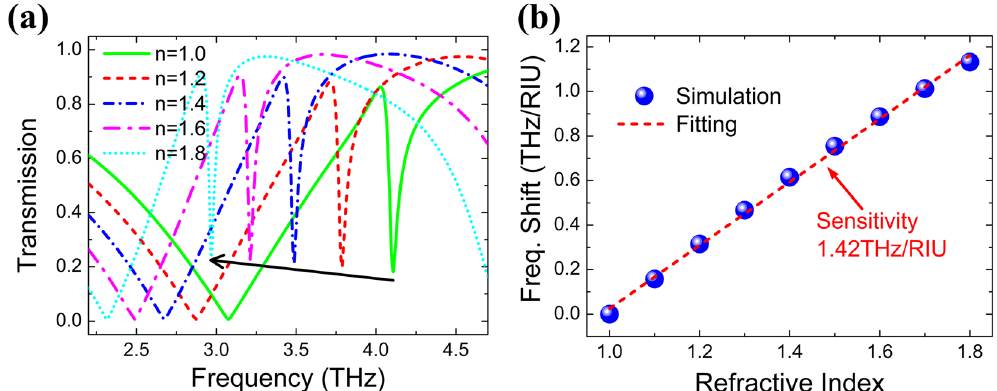
Figure 3. ( a ) Transmission spectra with refractive indices of the analyte changing from 1.0 to 1.8. ( b ) Frequency shift versus different refractive indices of the analyte, blue spheres are the simulation data, and red dotted line shows the linear fitting to the simulation data.